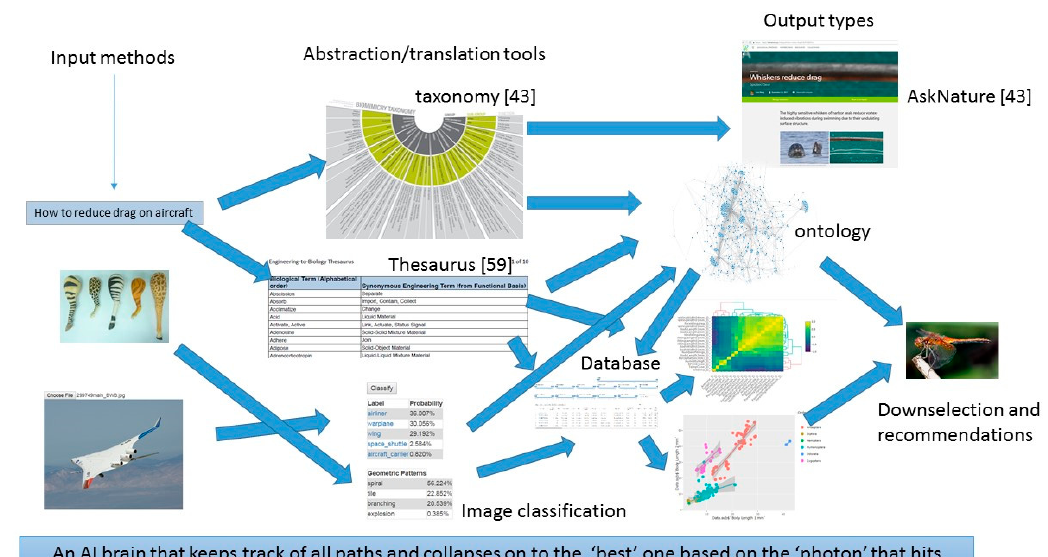
Figure 22. A few pathways available to select biological models for inspiration when solving a